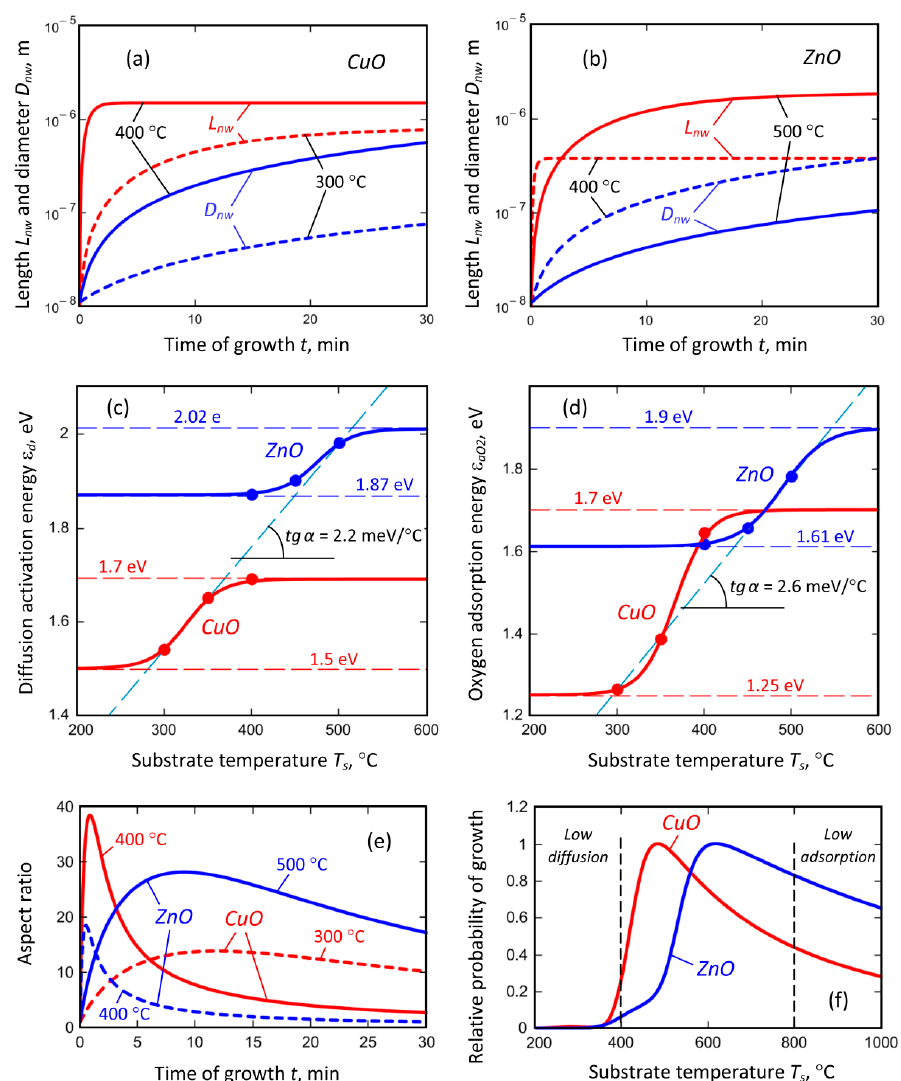
Figure 9. Results of calculations of the oxide dynamics: ( a , b ) dependencies of the nanowire length and diameter on the growth time; ( c , d ) dependencies of the copper diffusion activation energy and oxygen adsorption energy on the growth temperature; ( e ) nanowire aspect ratio at dependence on the time of growth; ( f ) relative probability of the nanowire growth at dependence on the substrate temperature.